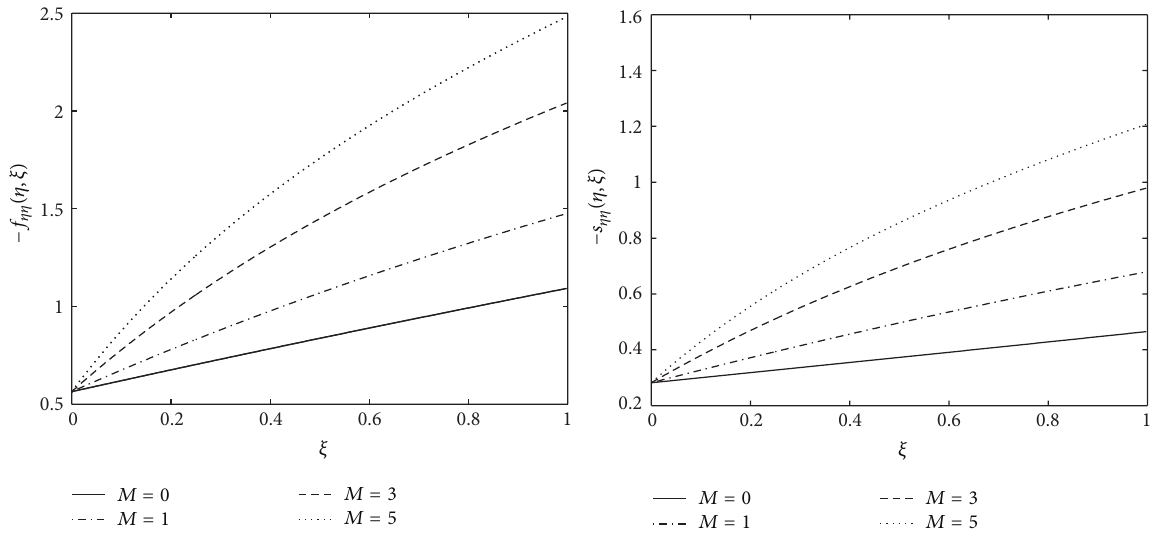
Figure 2: CFDRM solution of −𝑓 󸀠󸀠 (0,𝜉) and −𝑠 󸀠󸀠 (0, 𝜉) for different values of 𝑀 when 𝑐 = 0.5 and Pr = 0.7 .